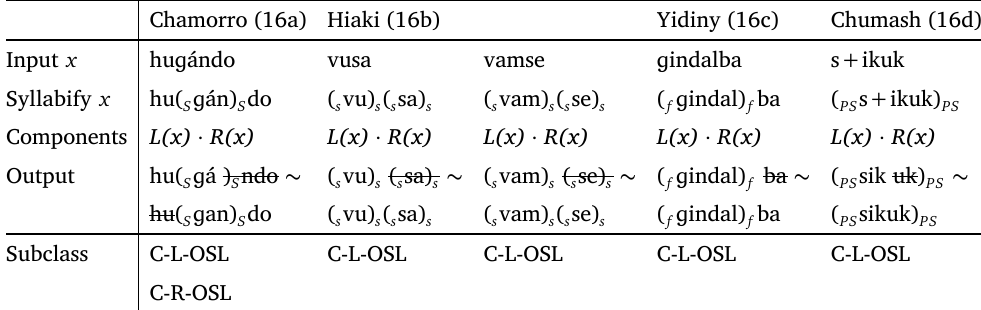
Table 6: C-OSL treatment for copying prosodic subconstituents Chamorro (16a) Hiaki (16b) Yidiny (16c) Chumash (16d)